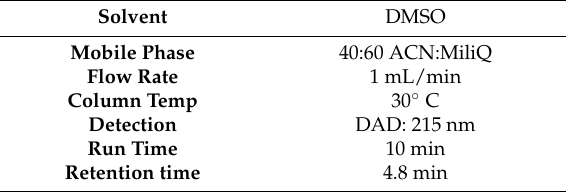
Table 2. Experimental condition maintained for HPLC experiments for